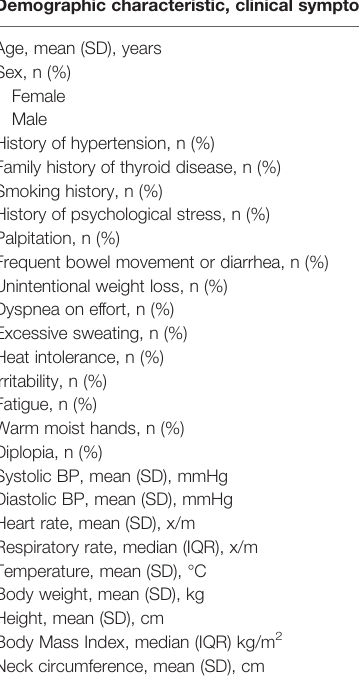
TABLE 1 | Baseline demographic characteristic, clinical symptoms, and physical examination of study participants. Demographic characteristic, clinical symptoms, and physical